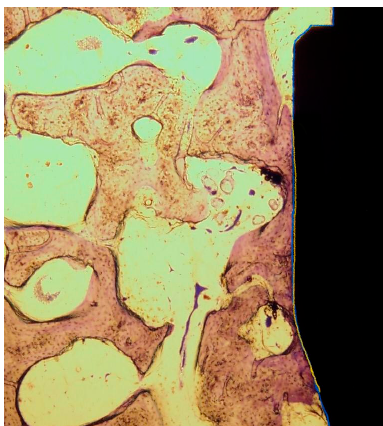
Figure 3. Histomorphometric evaluation of the bone-to-implant-contact (BIC) (blue = entire implant surface, yellow/blue = bone-covered implant surface).